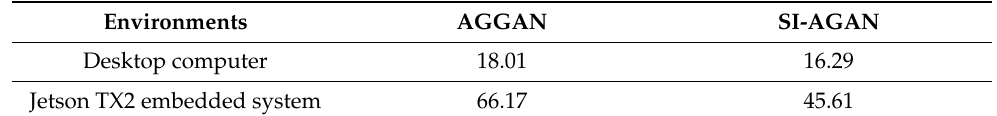
Table 18. Comparison of the average processing time between AGGAN and SI-AGAN. (unit: ms). Environments